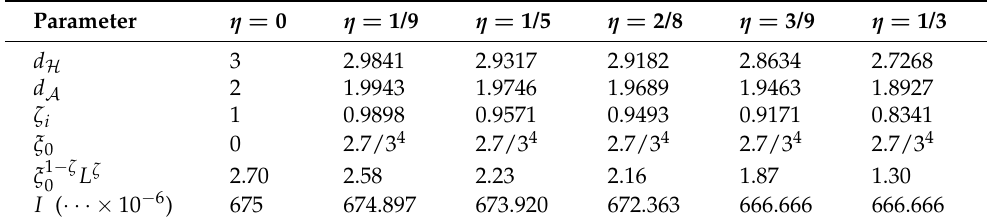
Table 1. Fractal parameters of the